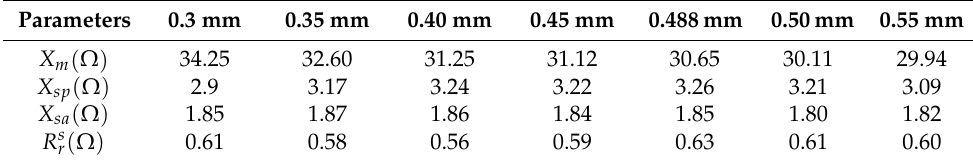
Table 7. Parameters of the motor from the FEA with 86 µ F.